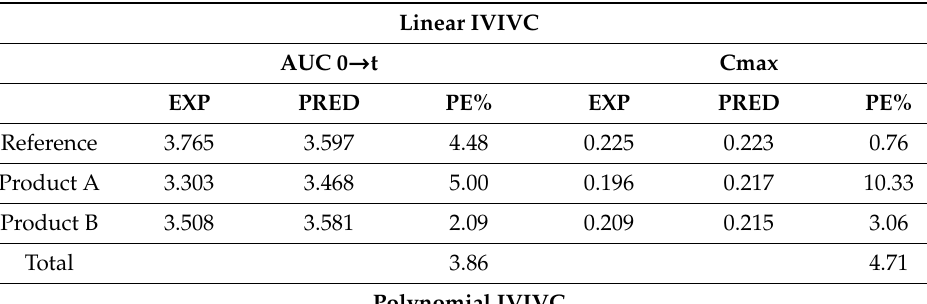
Table 5. Prediction errors of Cmax and AUC values of the two-step in vitro–in vivo correlations (IVIVC) (linear and polynomial).